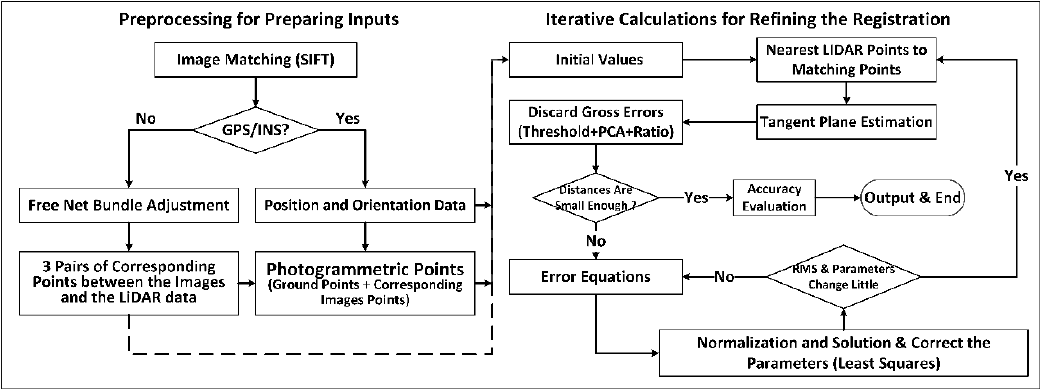
Figure 2. Implementation flow of the registration of aerial optical images with LiDAR data.